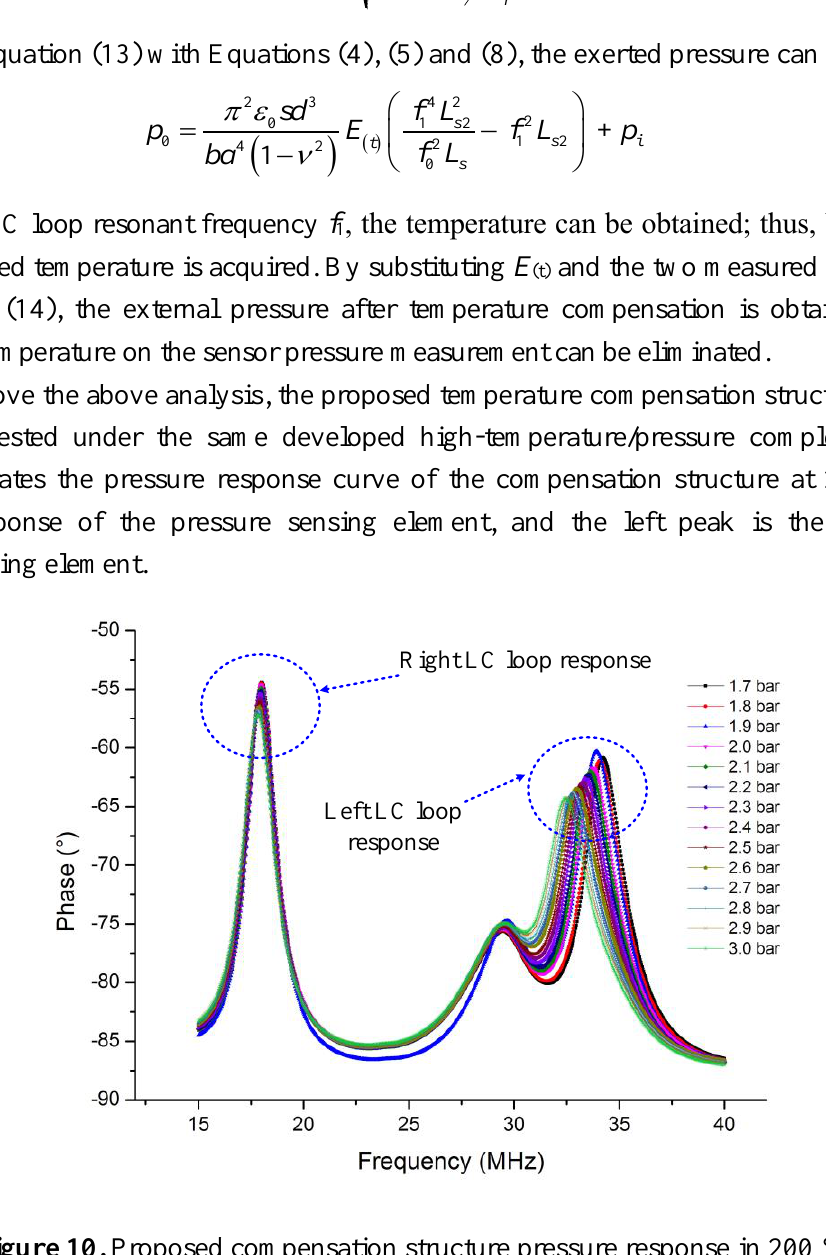
Figure 10. Proposed compensation structure pressure response in 200